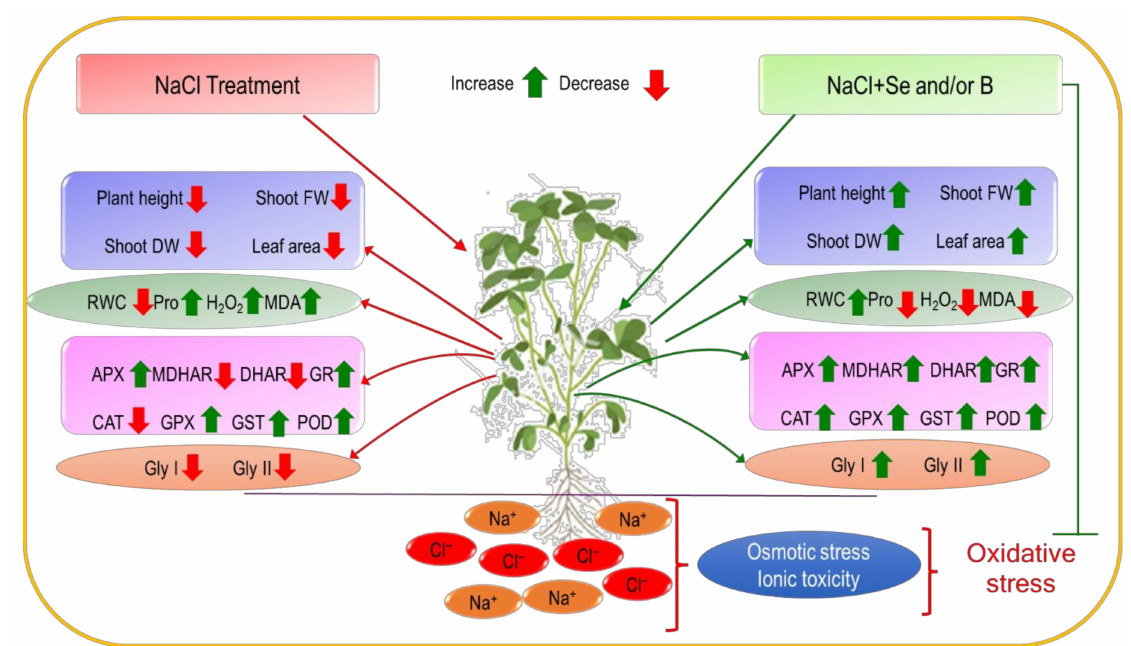
Figure 6. Schematic presentation of the protective roles of exogenous Se and B under salt